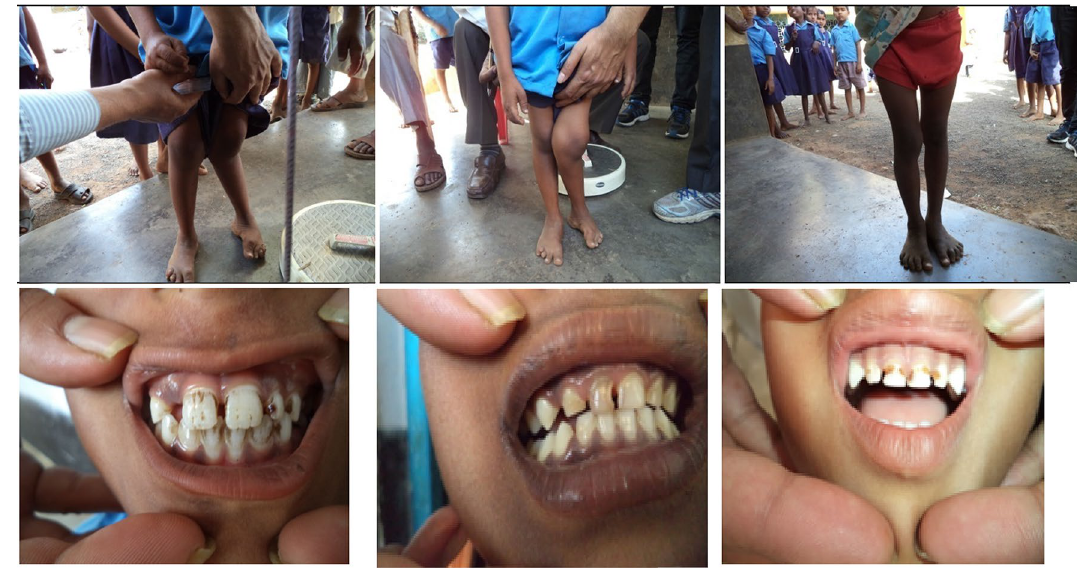
Fig. 9 Children affected by skletal and dental fluorosis in the study area